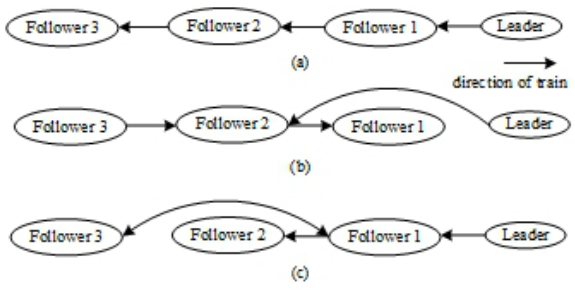
Fig. 1. Communication switching topology of